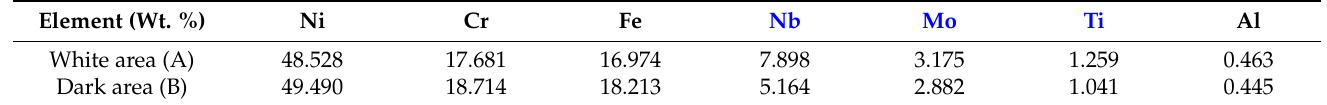
Figure 8. High-magnification SEM graphs of cellular dendrites and columnar dendrites in the X–Z plane of SLMed IN718 samples with different laser volume energy densities; ( a , d ) 85.86 J/mm 3 , ( b , e ) 100 J/mm 3 , and ( c , f ) 117.17 J/mm 3 .